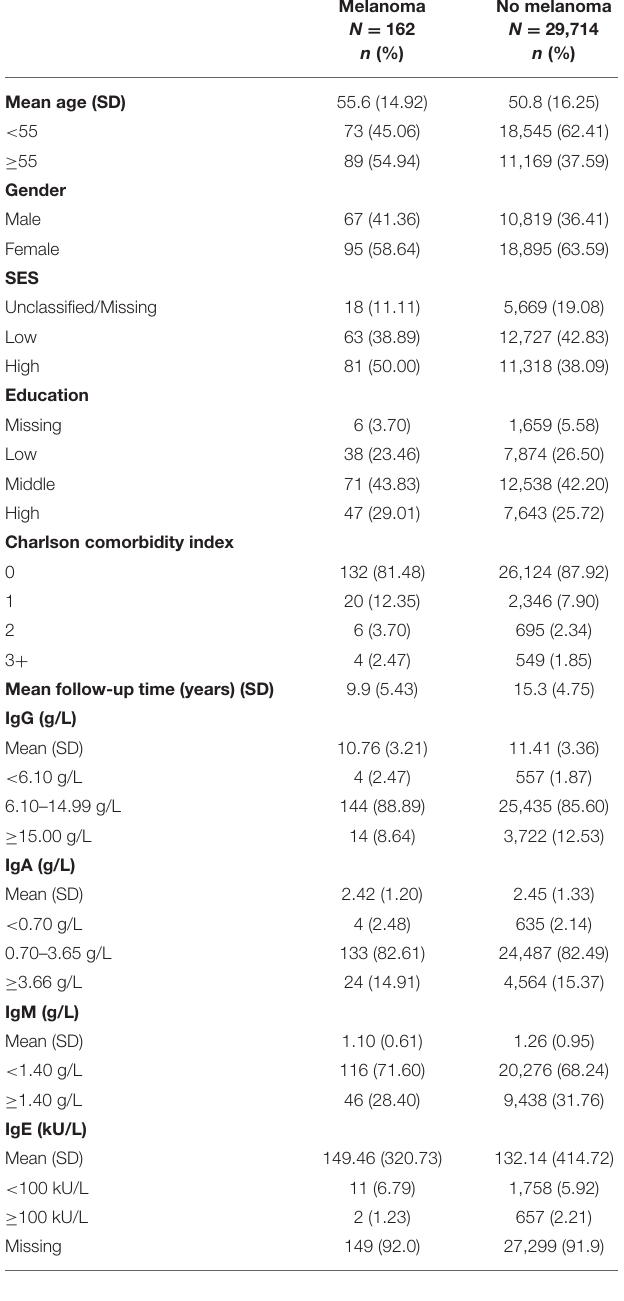
TABLE 1 | Descriptive statistics of study population. TABLE 2 | Hazard ratio (HR) for risk of melanoma with 95% confidence intervals